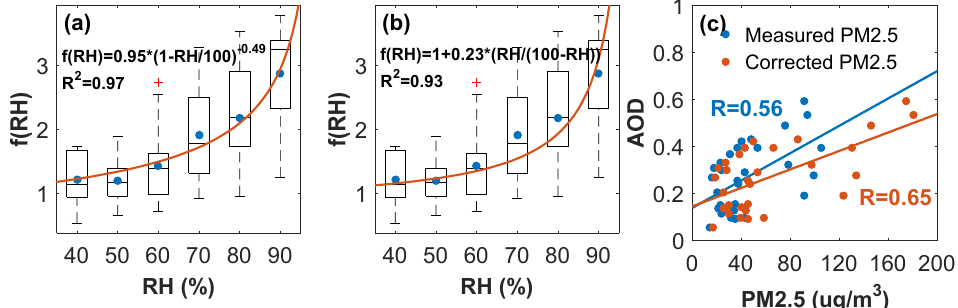
Figure 2. Parameterization of aerosol scattering hygroscopic growth based on ( a ) the two-parameter fitting equation and ( b ) the kappa equation. ( c ) Hygroscopic correction of satellite-based AOD during winter. Measured PM 2.5 is dry PM 2.5 , and corrected PM 2.5 is dry PM 2.5 multiplied by hygroscopic growth factor.